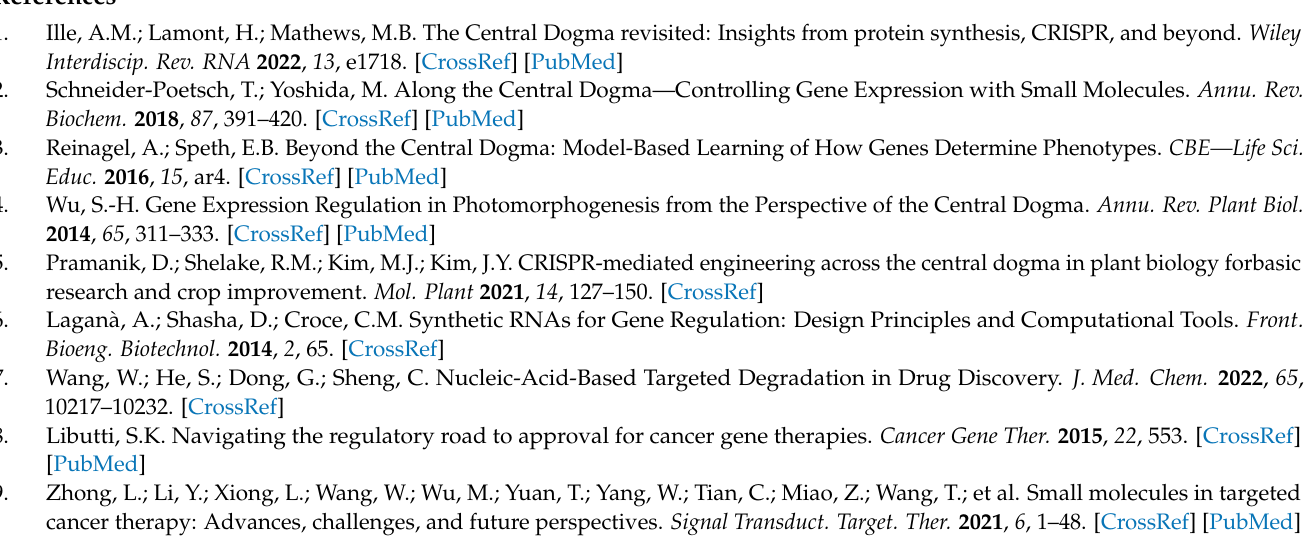
Table S4: Primer sequences of L-TP53-shMYC; Table S5: DNA sequence of L-TP53-shMYC cassette; Table S6: DNA sequences of F 3 and R 3 primers; Figure S1: Serum stability assay; Figure S2: The expression of p53 proteins and c-Myc proteins was quantified by Western blotting; Figure S3: Flow cytometry assay of anticancer activity of NP-EGFP; Figure S4: Flow cytometry assay of anticancer activity of NP-TP53; Figure S5: Quantitative analysis of the relative expression fold of MYC mRNA and TP53 mRNA in the tumors at 7 days post-administration; Figure S6: Western blotting analysis of p53 protein and c-Myc protein of tumor tissues at 7 days post-administration; Figure S7. Histochemistry staining images of organs and tumor tissues from mice sacrificed on the 16th day after treatment with various nanovectors; Figure S8. Analysis of immune cytokines levels (IL-6, TNF- α and IFN- γ ) in the serum from mice sacrificed on the 16th day after treatment with various